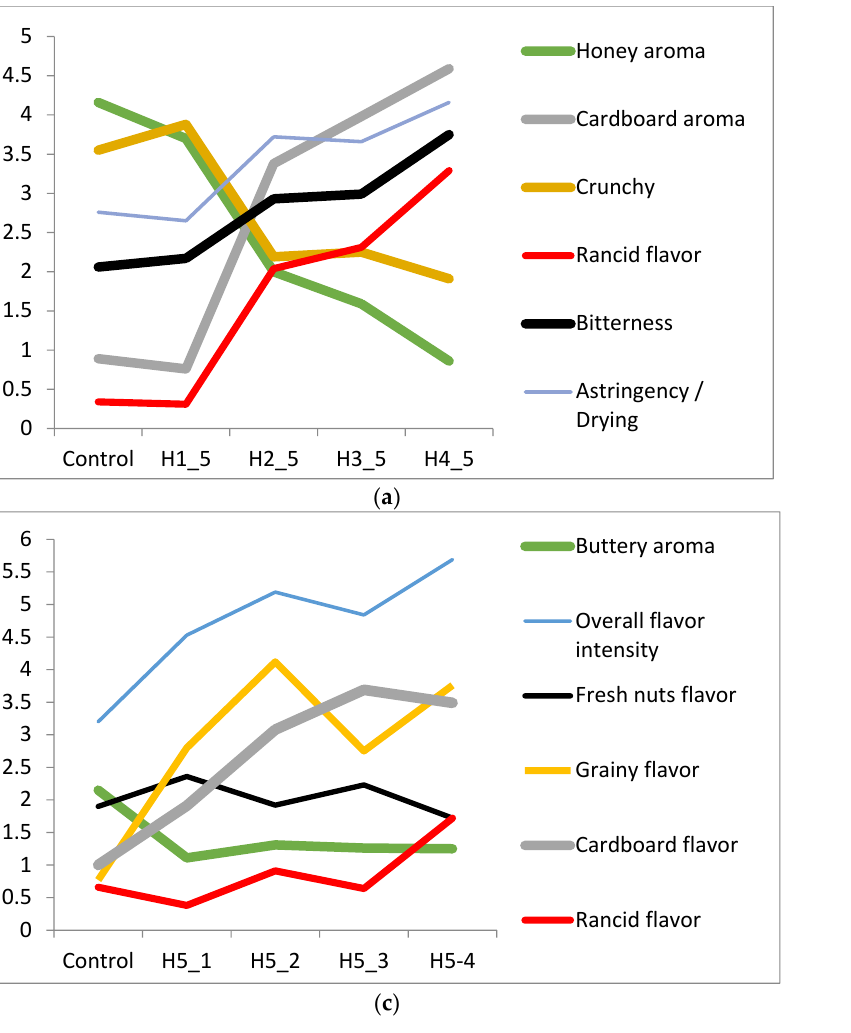
Figure 3. ( a – d ) Changes in sensory attributes of Howard kernel (( a ) 5 °C; ( b ) 23 °C) and oil (( c ) 5 °C; ( d ) 23 °C) for 4 months.